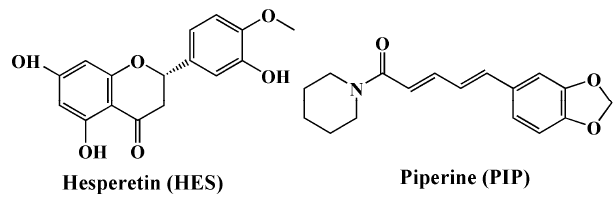
Figure 1. Chemical structures of HES and PIP.